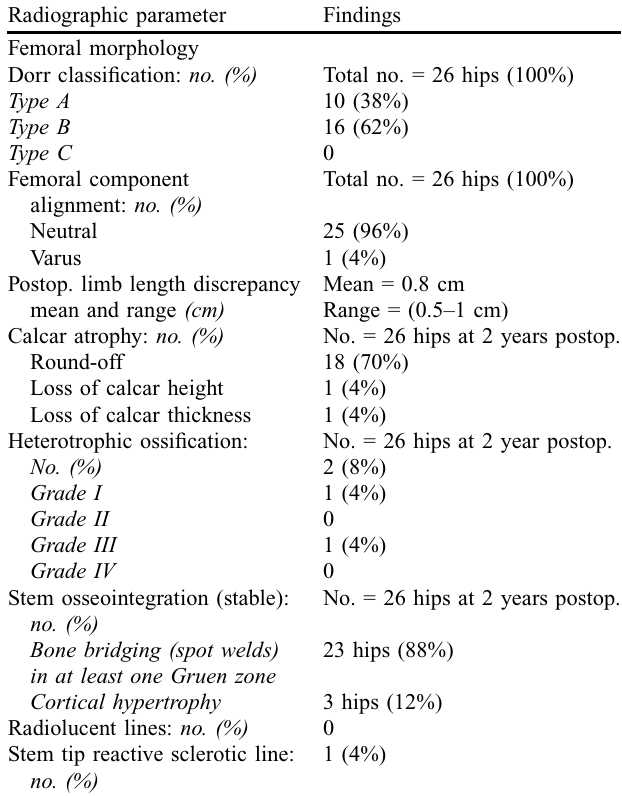
Table 3. Summary of immediate and post-operative follow-up radiographic results.